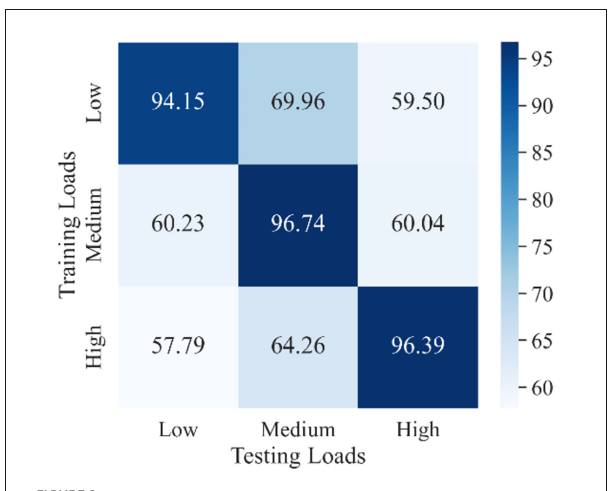
FIGURE9 Confusion matrix of classification results for all subjects under every single load using a one-step method. Each element represents the accuracy of all subjects for corresponding training and testing loads. Darker color indicates higher accuracy. The main diagonal elements represent the accuracies where the load of training and testing sets are the same. The off-diagonal elements represent the accuracies where the load of training and the testing sets are